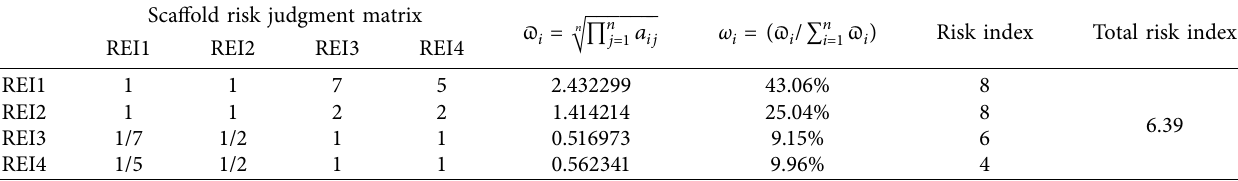
Table 28: Scaffold risk judgment